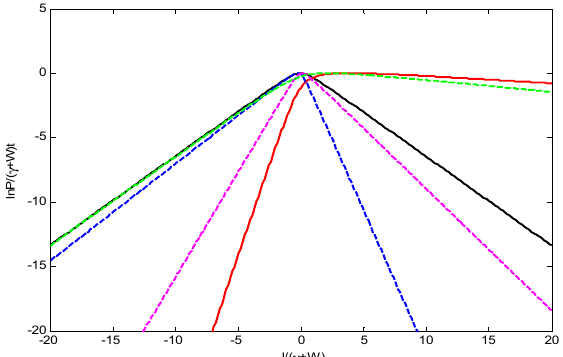
Figure 6. Large-deviation statistics of the net photon emission current. Numeric results for the distribution of the net photon emission current J from a cavity to reservoir with ∆ = − 5 Γ (blue line); ∆ = 5 Γ (red line); ∆ = 0 (magenta line); DQDs replaced by thermal reservoir γ (cid:3035) = 0.02, 𝑛(cid:3364) (cid:3035) = 1 (black line), thermal bath γ h = 0.02, n h = 10 (green); γ = 0.02, n = 1, Γ = 1, ω m = 10 Γ , η = 0.05, Ω (cid:2868) = 7𝛤 .